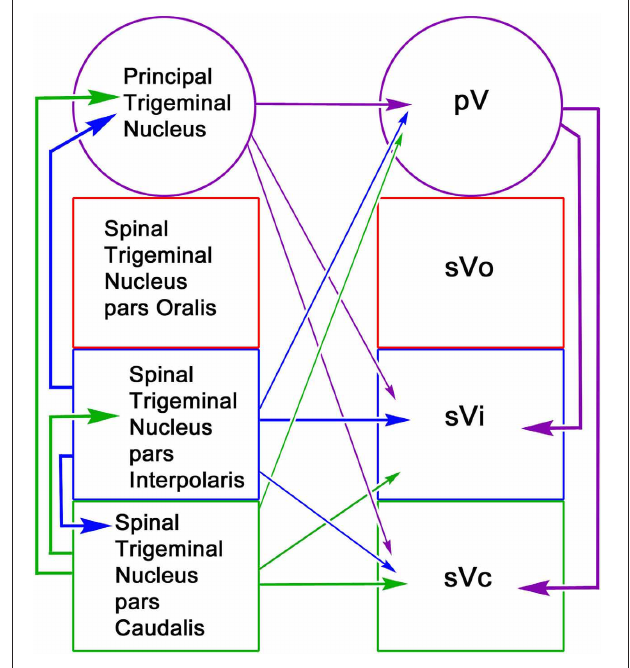
FIGURE 15 | Schematic of reciprocal intratrigeminal connections demonstrated in this study. The thickness of the lines indicates the strength of the projection. For simplicity, the connections of the pV/sVo are indicate by arrows to pV, since we did not distinguish between the subnuclei in the experimental material. All possible connections are present. The arrows are color coded based on the location of the cells of